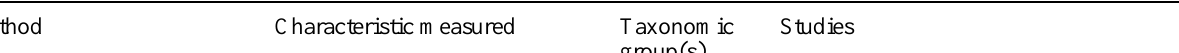
Table 1 . Current tools used for the study of nonbreeding parameters in diverse seasonal migrant taxa and some of their